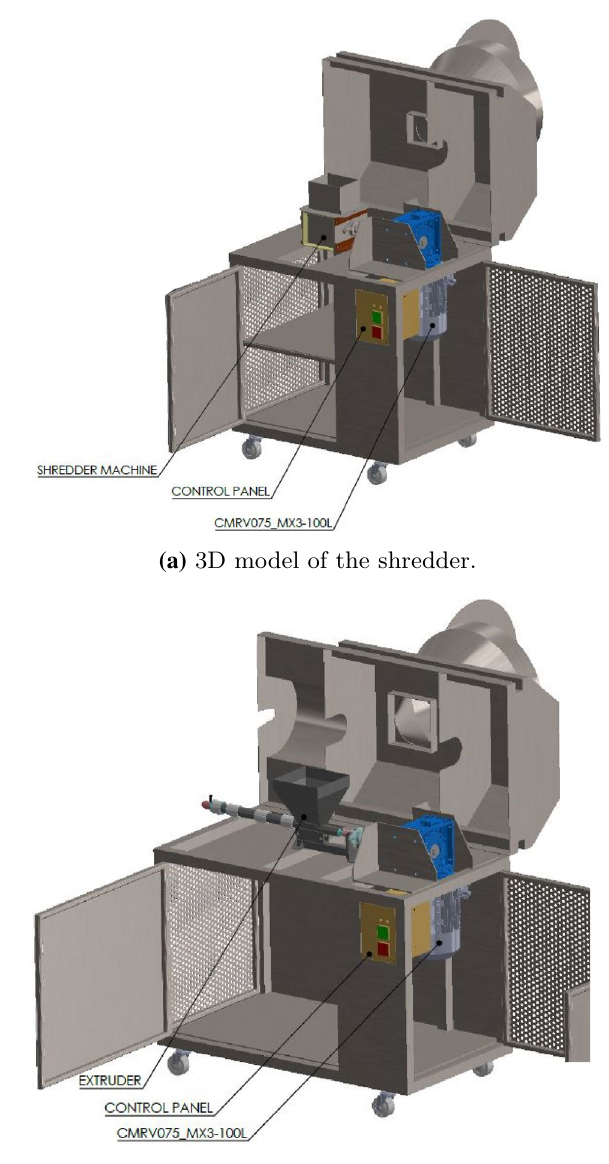
(b) 3D model of the extruder. Fig. 4 3D model of the shredder and